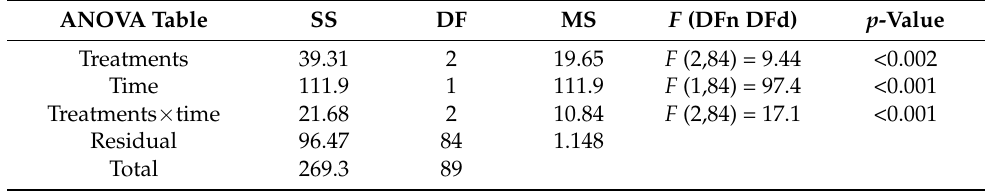
Table 2. Two-way ANOVA for respiration rate of Spodoptera frugiperda caterpillars upon exposure to lethal concentrations (LC 50 and LC 90 ) of deltamethrin for two times. DF = degrees of freedom; SS = sum of squares; MS = mean square; n = numerator; d = denominator; p = probability of signifi- cance; α = 0.05.